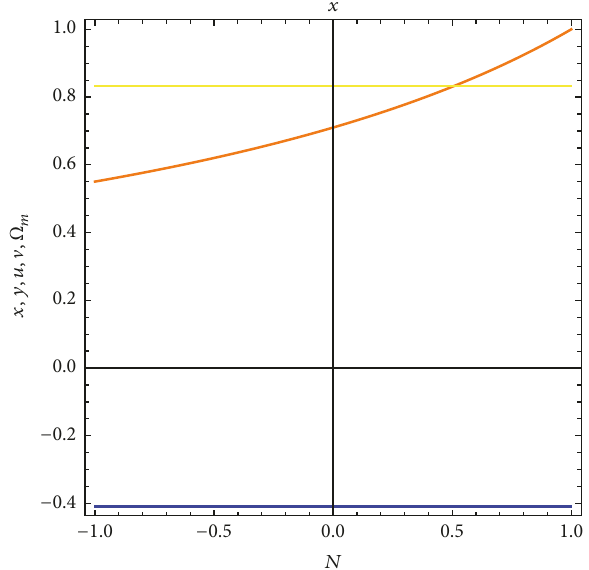
Figure 3: Plot of ( 3 ) variations of 𝑥 (blue), 𝑦 (green), 𝑢 (orange), V (red), and Ω 푚 (yellow) versus 𝑁 near 𝑃 4 , for 𝛾 = 4/3 , 𝛿 = 0.5 , and 𝜆 = −0.5 . The position corresponding to 𝑁 = 0 is the fixed point under